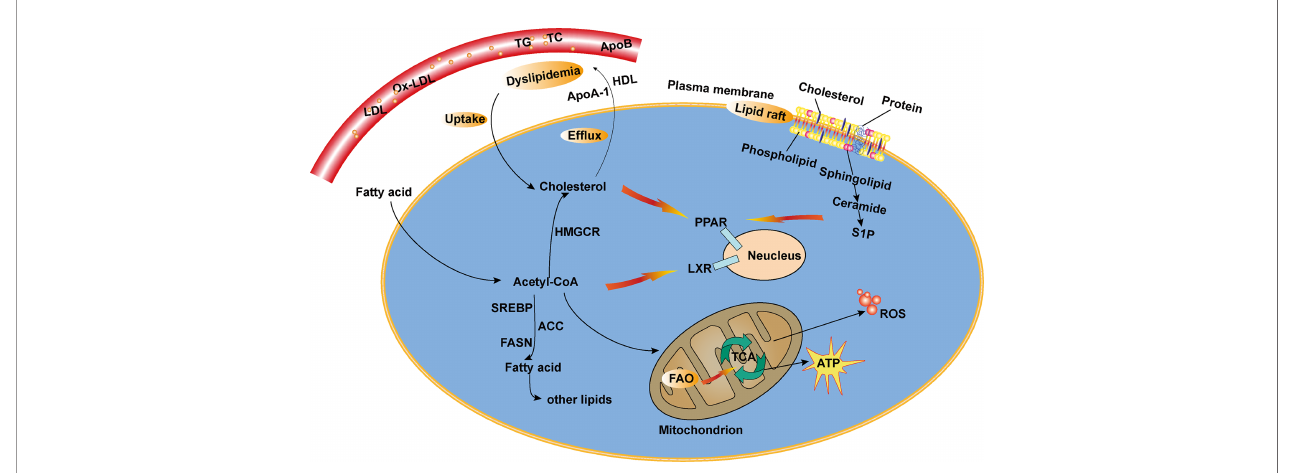
FIGURE 1 | A simpli fi ed schematic representation of lipid metabolism. Lipid metabolic networks mainly involve catabolism (fatty acid oxidation (FAO)), anabolism ( de novo lipogenesis) and storage as lipid droplets (LDs). Lipid raft are microdomains of the plasma membrane enriched in sphingolipids and cholesterol. The uptake of various lipids undergoes a series of processes and oxidation in the mitochondrion, which leads to the production of energy (substantial ATP) and ROS. Acetyl CoA, the end product of FAO pathway, can then either enter TCA cycle or synthesize multiple lipids, such as cholesterol and fatty acids. Lipids or derivatives of the lipid metabolism can activate transcription factors, including PPAR, LXR, then regulate activities of transporters to modulate downstream signals. Dyslipidemia, the disruption of lipid metabolism, is mainly characterized by elevated plasma levels of LDL, TG), TC), and reduced HDL.